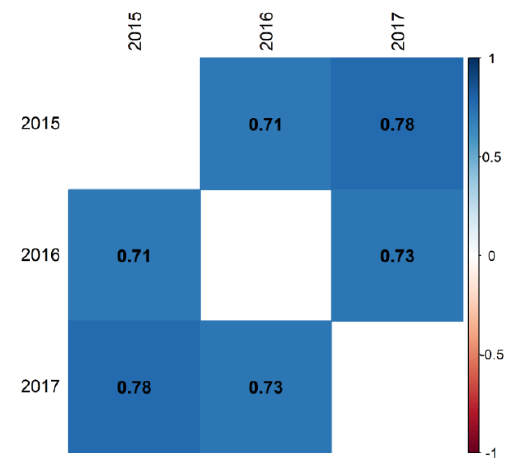
Figure 3. Spearman rank correlation coefficients of cultivars ’ white sugar yield between tested growing seasons.